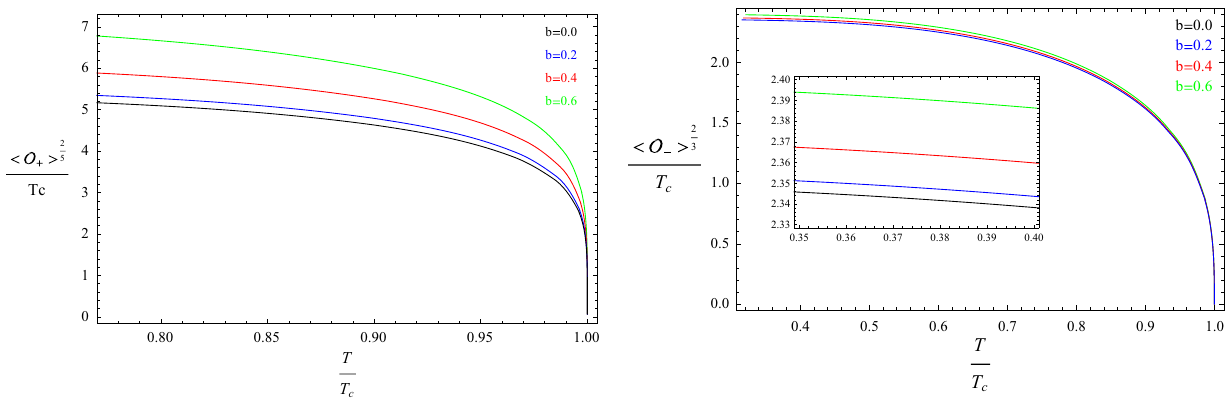
Fig. 1 The operators (cid:2) O + (cid:3) (left plot) and (cid:2) O − (cid:3) (right plot) with respect to the temperature T after condensation for different BI parameter. The four lines from top to bottom correspond to b = 0 (black), b = 0 . 2 (blue), b = 0 . 4 (red), and b = 0 . 6 (green)